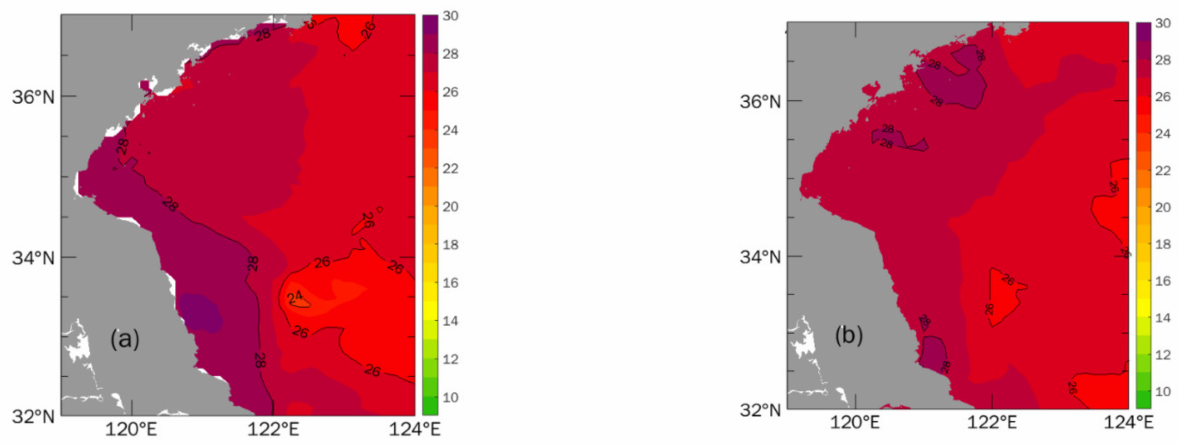
Figure 5. SST distribution in the first 10 days of August 2019 for ( a ) Exp.C and ( b ) MGDSSTs data.